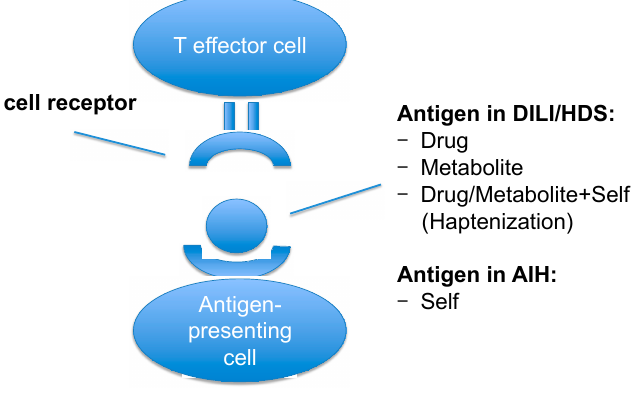
Figure 2. Antigen presentation in DILI/HDS and AIH.